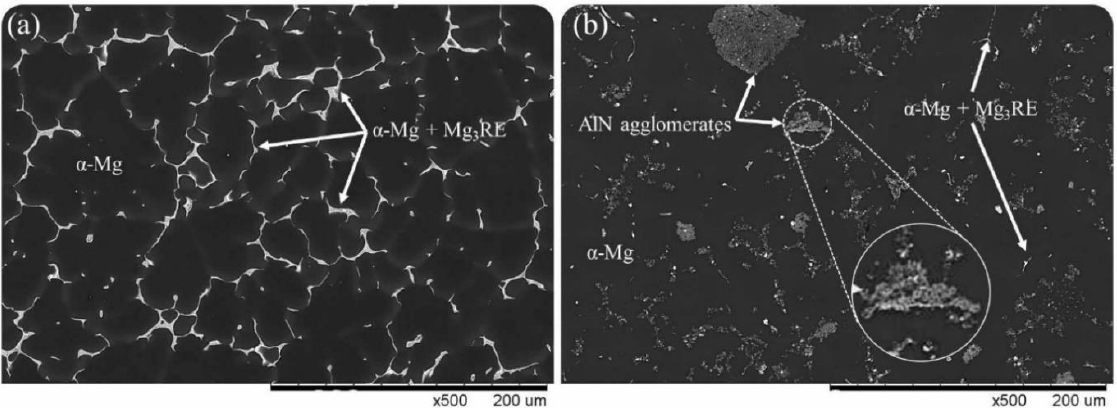
Figure 3. SEM micrographs of ( a ) as-cast modified EV31, ( b ) modified EV31-2%AlN.